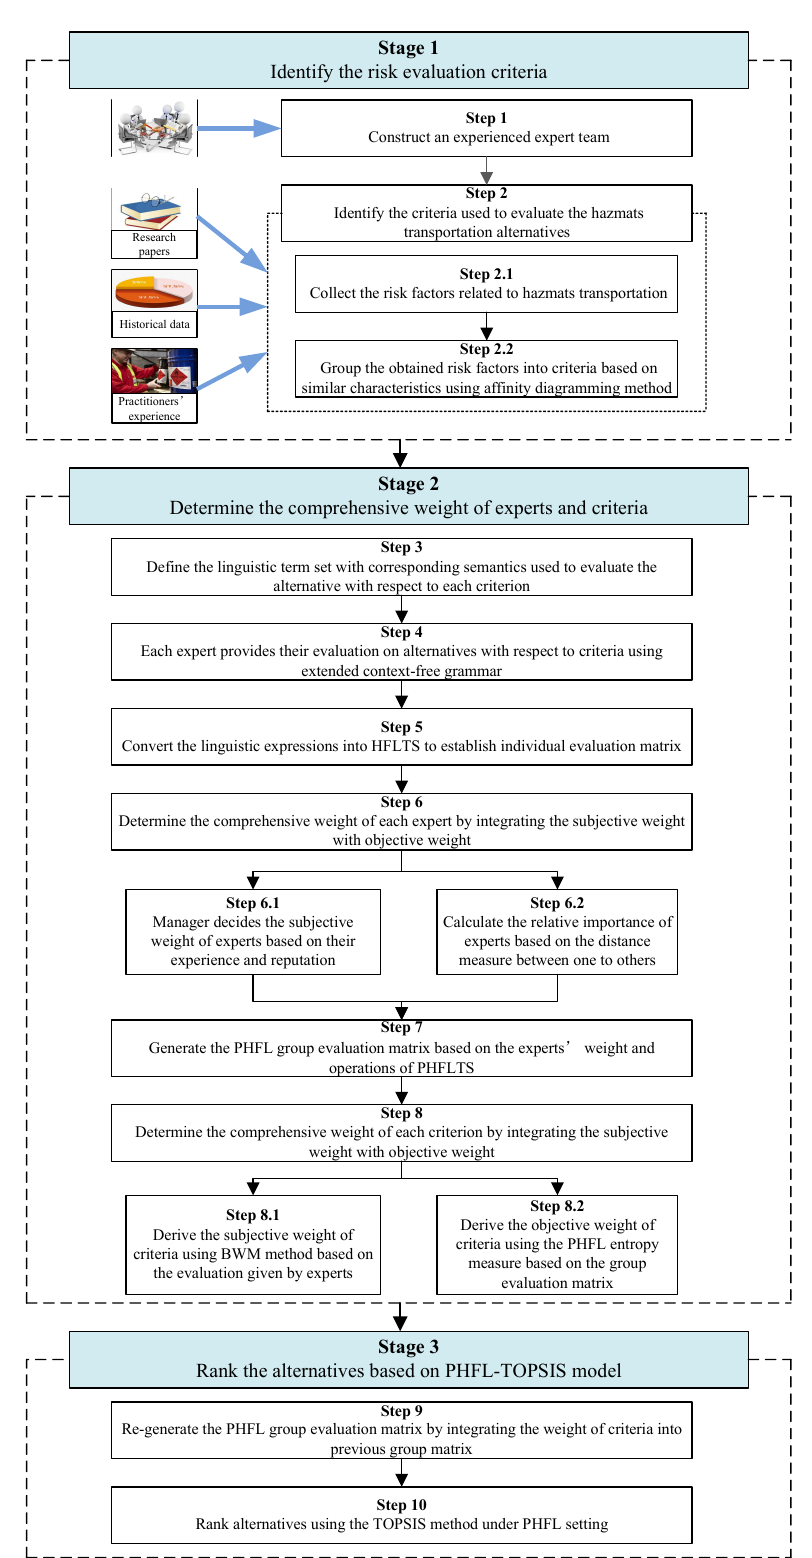
Figure 1. The flowchart of the proposed PHFL-TOPSIS model for alternative